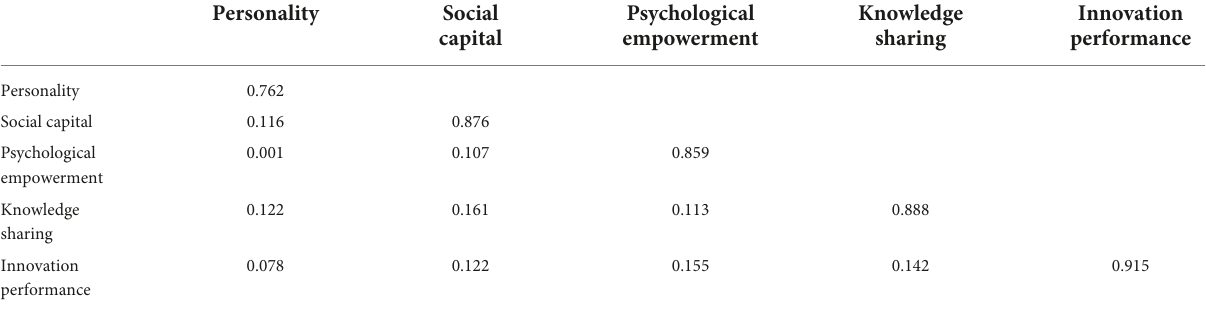
TABLE 4 Correlation matrix of latent